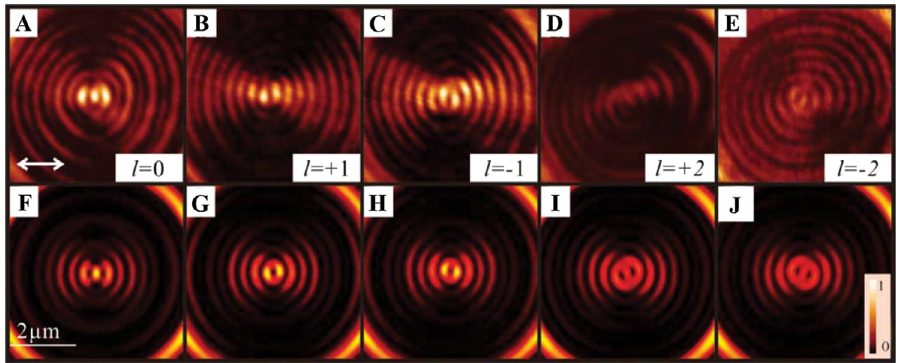
Figure 23 Intensity distribution of the optical field near the plasmonic antenna excited by light with different OAMs at the height of 200 nm over the antenna surface. (A)–(E) are the NSOM images for l = 0, +1, -1, +2 and -2, respectively. (F)–(J) are the corresponding numerical simu- lation results. Adapted from Ref.